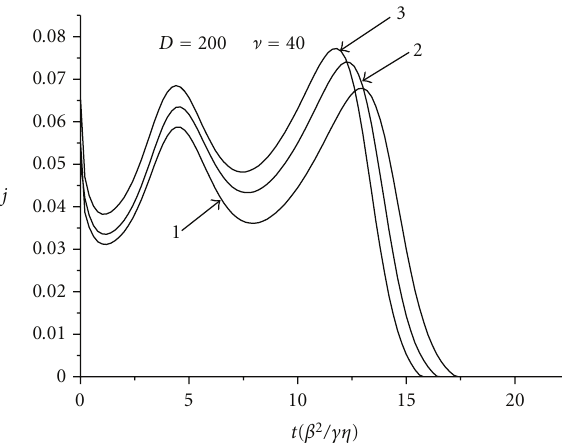
Figure 3: Dependence of the switching current j on time t (in units of γη/β 2 ) at polarization reversal process (transition from the stable state to the second stable state or from the first metastable state to the second one) in the 2D system. Calculations are carried out for temperatures in the vicinity of the phase transition ( δ = 1 . 017, δ = 0 . 9835) and for the values of the applied field in the vicinity of coercive field E c ( E = 0 . 95 · E c , E = 1 . 05 · E c ): (1) δ = 1 . 017, E = 0 . 95 · E c ; (2) δ = 0 . 9835, E = 0 . 95 · E c ; (3) δ = 0 . 9835, E = 1 . 05 · E c . At δ = 1 . 017, the two minima corresponding to the ferroelectric metastable domains are above the minima corresponding to the paraelectric stable phase at zero electric field, while at δ = 0 . 9835 the situation is reversed. The number of dipoles is 64 × 64. The initial state corresponds to the ferroelectric state with a nucleus of the second domain of polarization oriented in the opposite direction (the size of the nucleus is 4 × 4). The values of coe ffi cients D and ν correspond to those for BaTiO 3 , D = 200, ν = 40 .